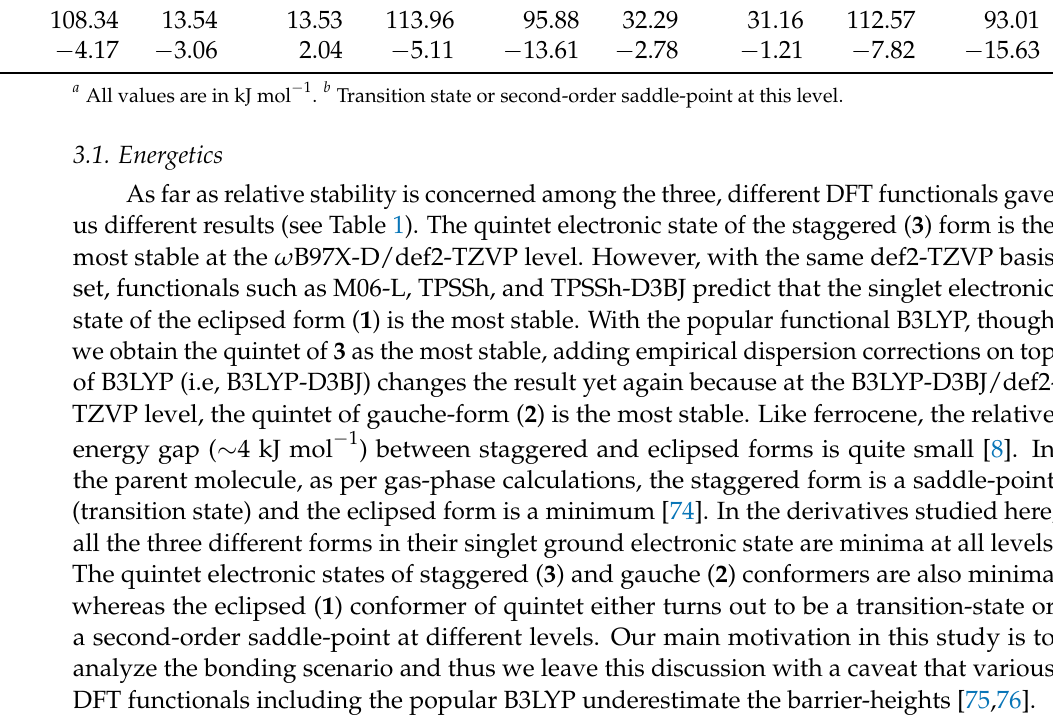
0 ) and thermally corrected Gibbs energies ( 1 ) using def2-TZVP basis set